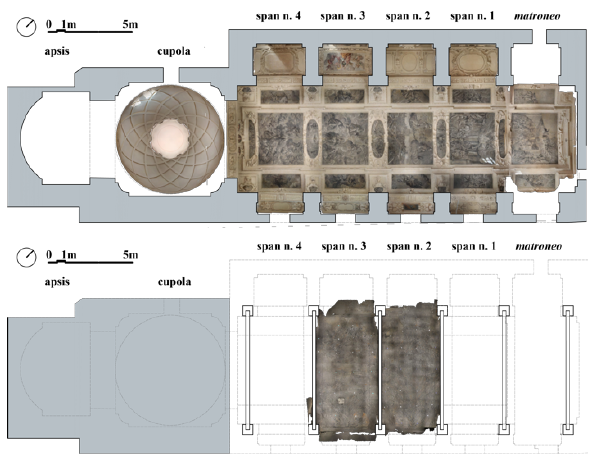
Figure 2. Orthomosaic of intrados (top) and extrados (bottom) of the Italian Cultural Institute